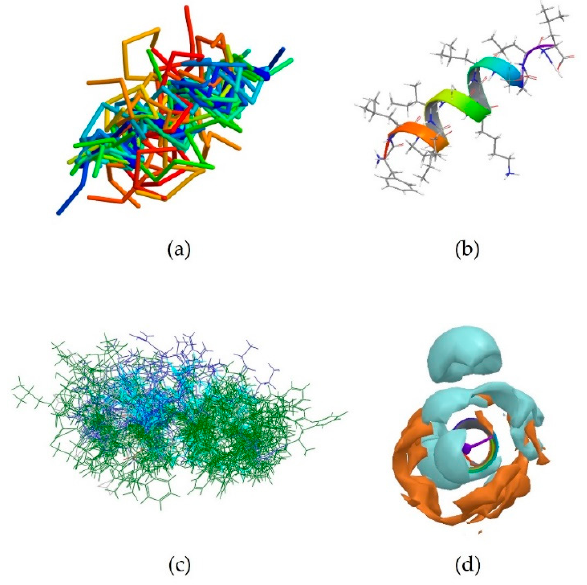
Figure 9. ( a ) Backbone superposition of all members of cluster 1 onto the centroid VCP-VT1 (thick blue trace); ( b ) Predicted conformation of VCP-VT1 after 1.2 ns MD simulation; ( c ) The peptides belonging to cluster 6 are shown superimposed and the residues are coloured according to their electrical properties: hydrophobic residues in green, positively-charged in blue, polar uncharged in cyan. A few peptides also contain negatively-charged residues (red), however the overall charge of the molecule is still positive. Two distinct areas can be observed, with a positively-charged portion and a predominant hydrophobic or uncharged region; ( d ) The surface of the centroid CVP-VT1 is shown along the N -terminal side, with hydrophilic areas in cyan and hydrophilic regions in amber. A clear distinction can be observed between the two.